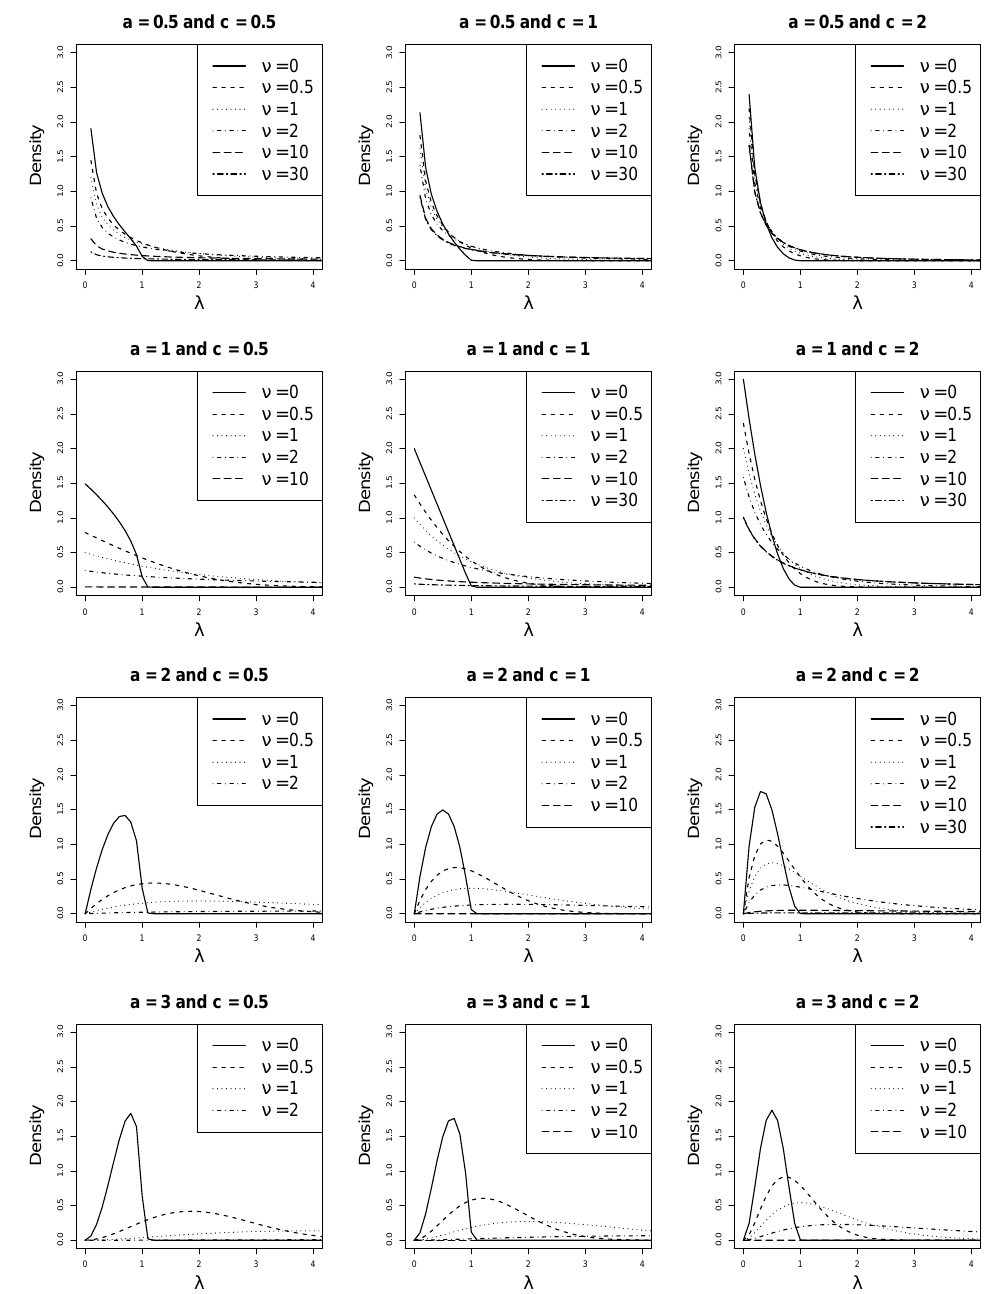
Figure 1. Plots of the conditional conjugate probability density function h ( λ | ν ) at select values of a , c and ν